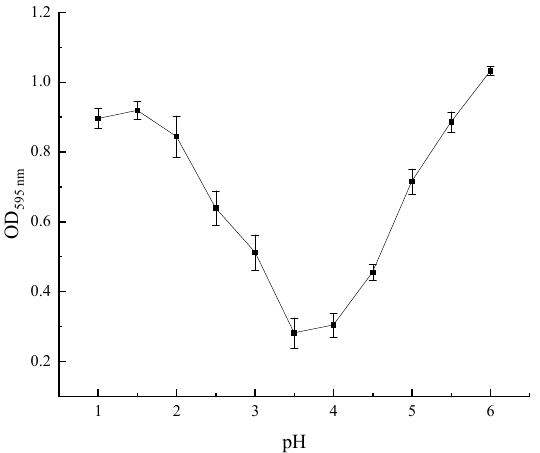
Figure 8. Effect of pH on the optical density of the supernate.